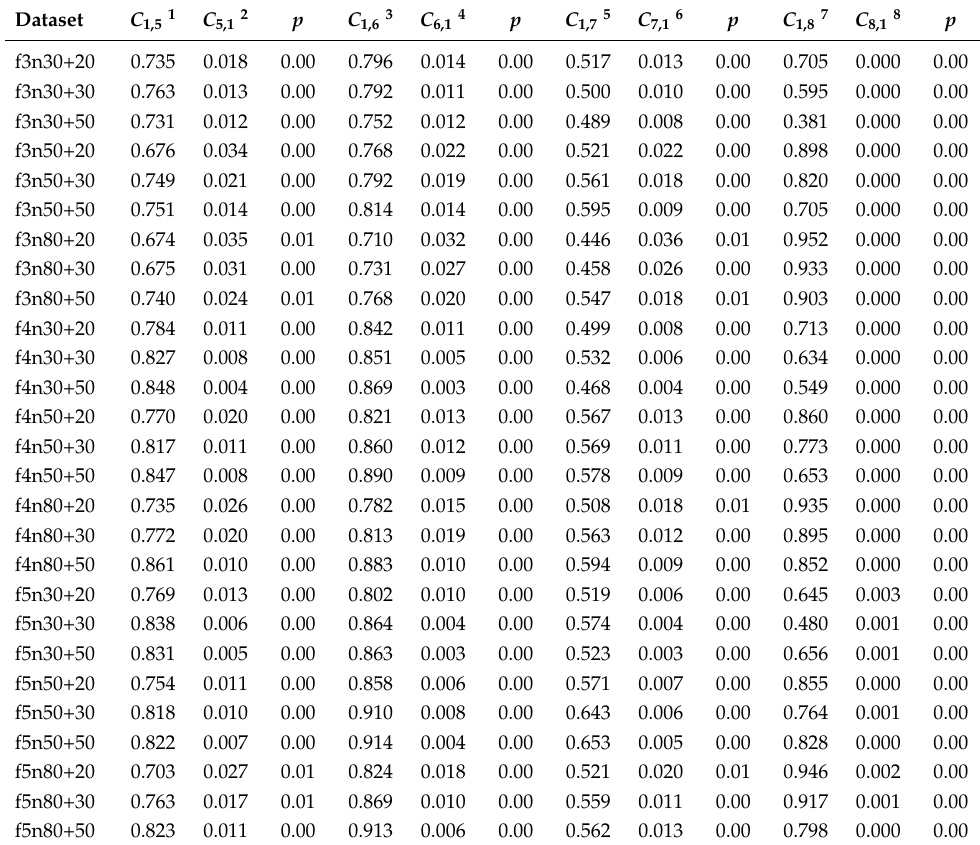
Figure 6. Boxplots of C Metric of KCDE, NSGA-II, MOEA/D, BCMA and DCMA. Table 7. Average C Metric Values of KCDE and NSGA-II, MOEA/D, BCMA,